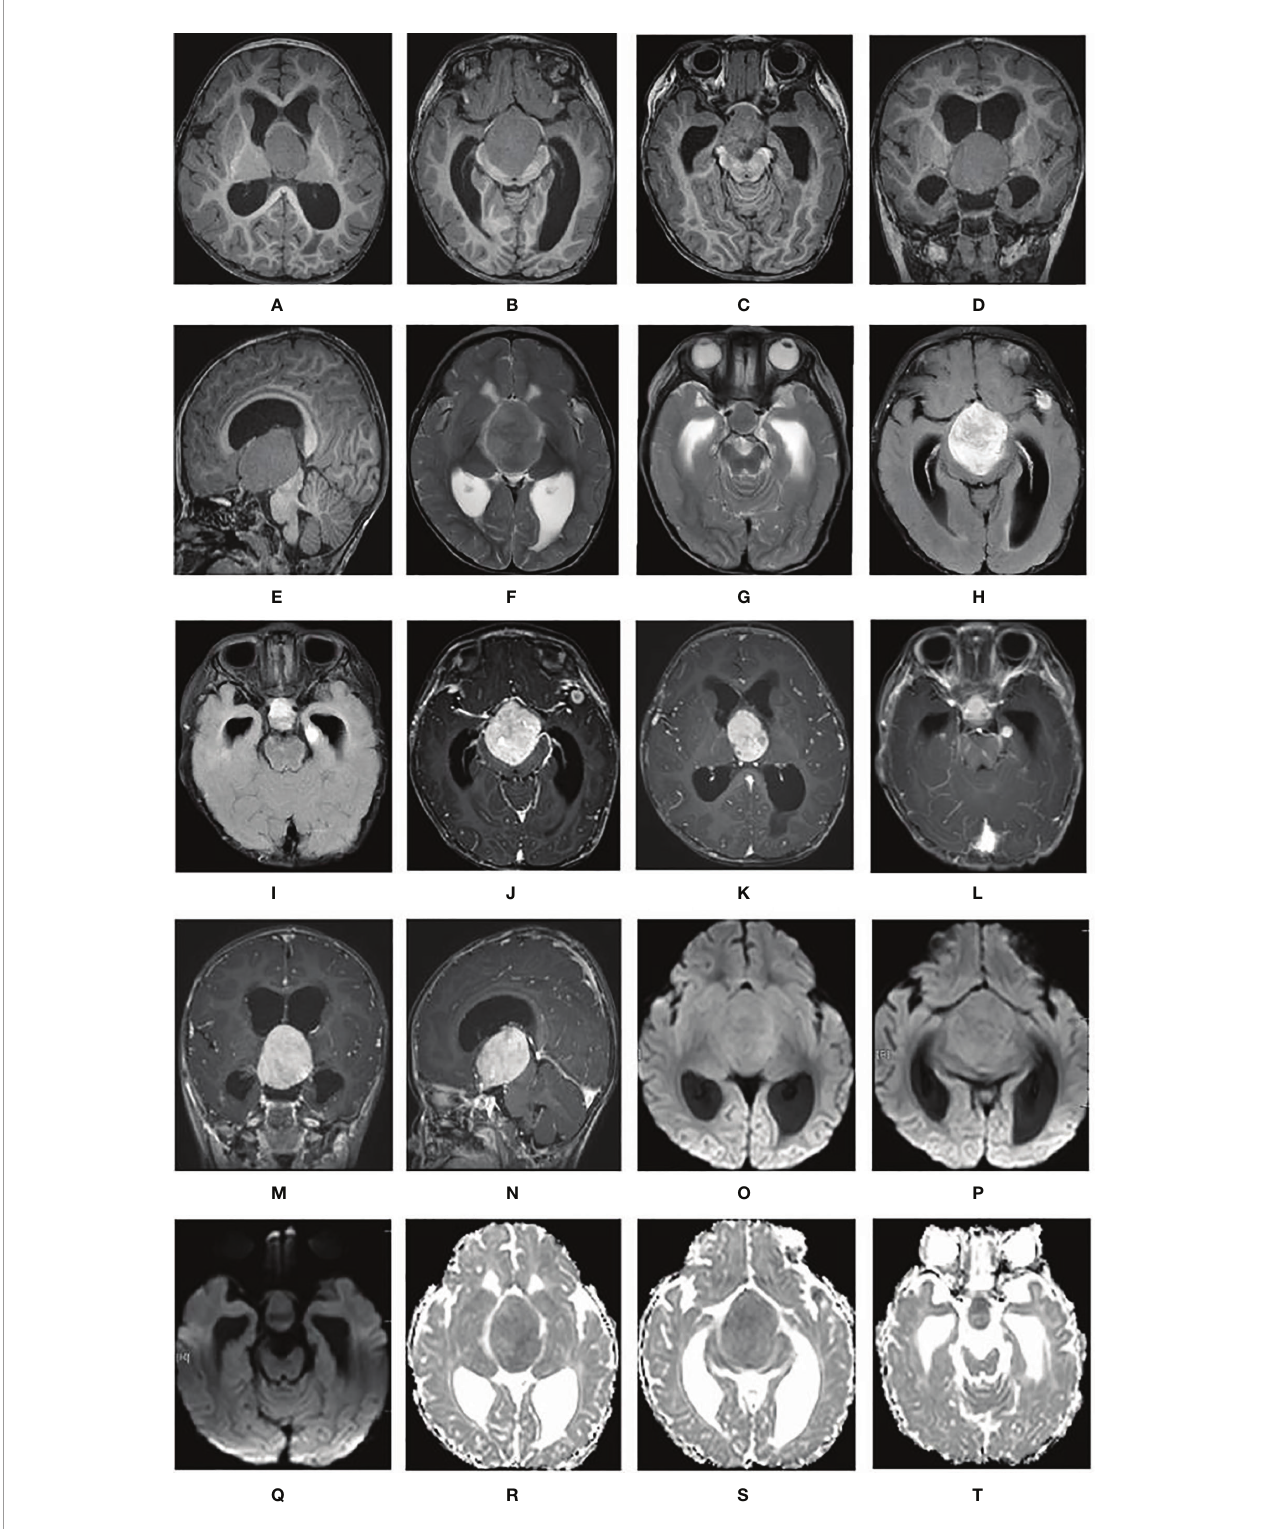
FIGURE 1 | Cerebral lesions are seen on MRI. (A – E) T1-weighted MRI; (F, G) T2-weighted MRI; (H, I) fl uid-attenuated inversion recovery MRI; (J – N) contrast- enhanced T1-weighted MRI; (O – Q) diffusion-weighted imaging; and (R – T) apparent diffusion coef fi